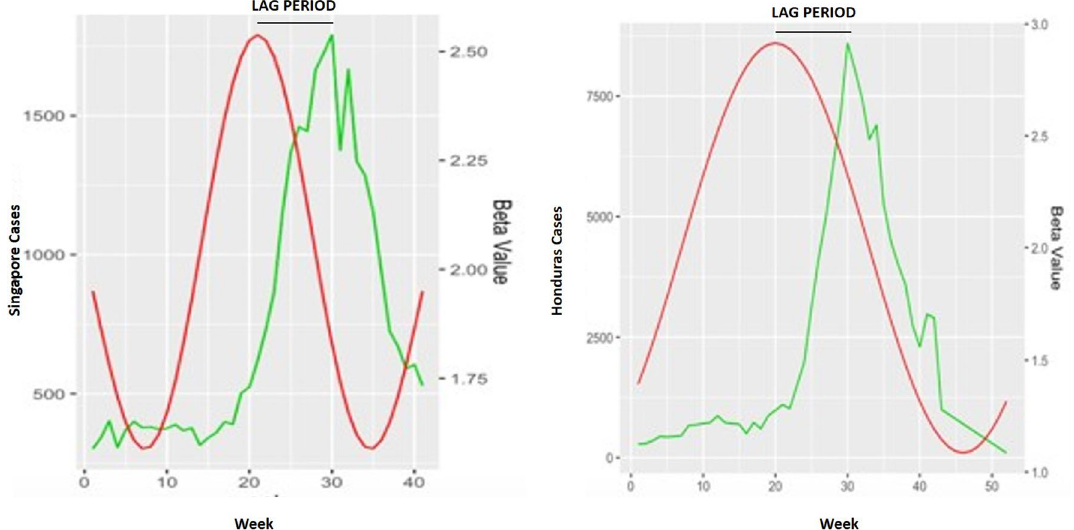
Figure 9. Graph showing the null model analysis exhibiting the trigonometric beta estimates (red) and the cases (green) for Singapore and Honduras. The lag period of about 12–14 weeks is shown for both the